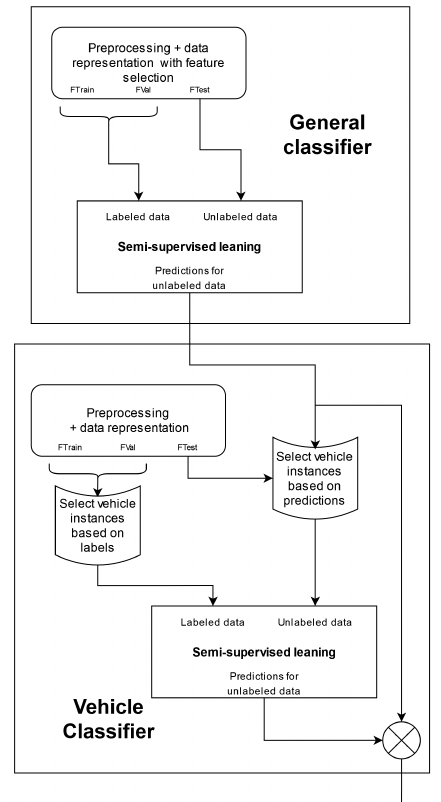
Figure 7. A diagram of the classification pipeline used for the data from